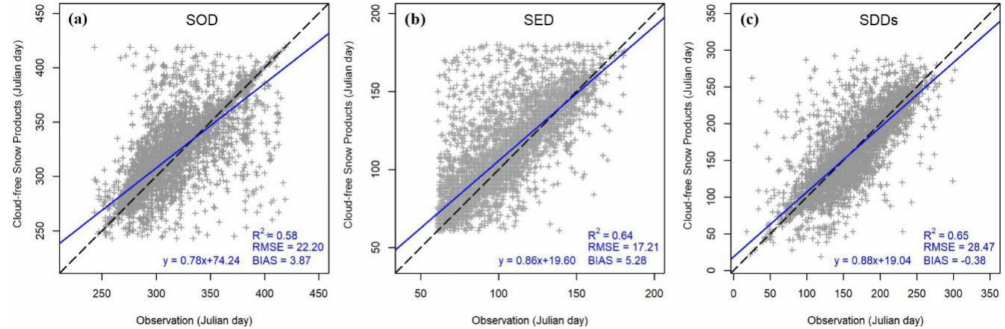
Figure 16. Cross-validation of snow phenology parameters (( a ) SOD, ( b ) SED, ( c ) SDDs) between cloud-free snow cover product and ground observations. The blue line is the linear fit between cloud-free snow cover product and ground observations. The grey points show the agreement between cloud-free snow cover product and ground